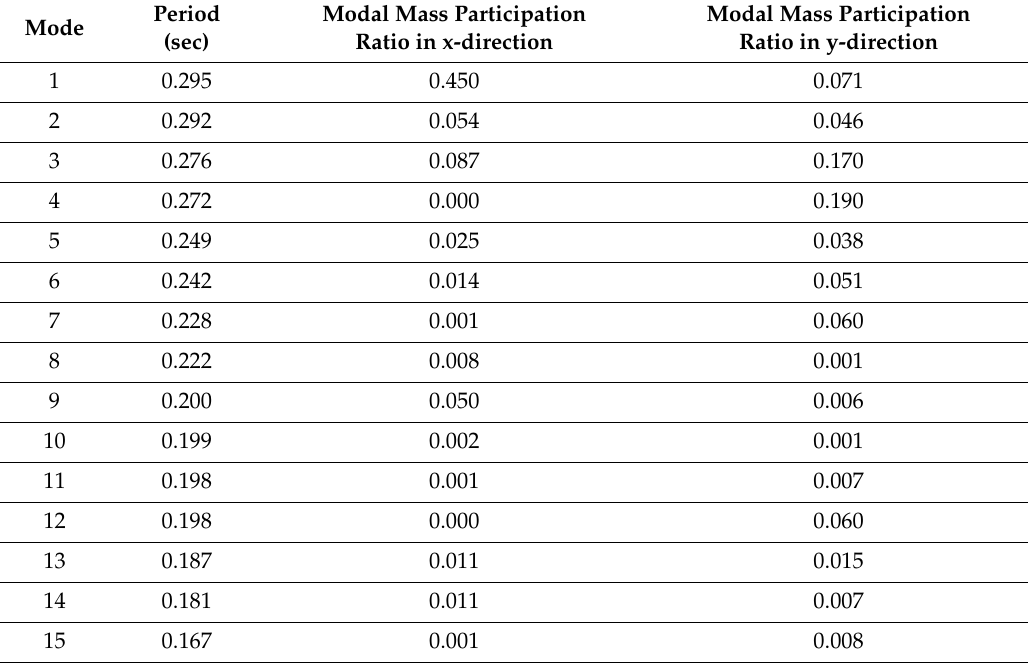
Table 2. Summary of modal mass participation in x- and y-direction in the first 15